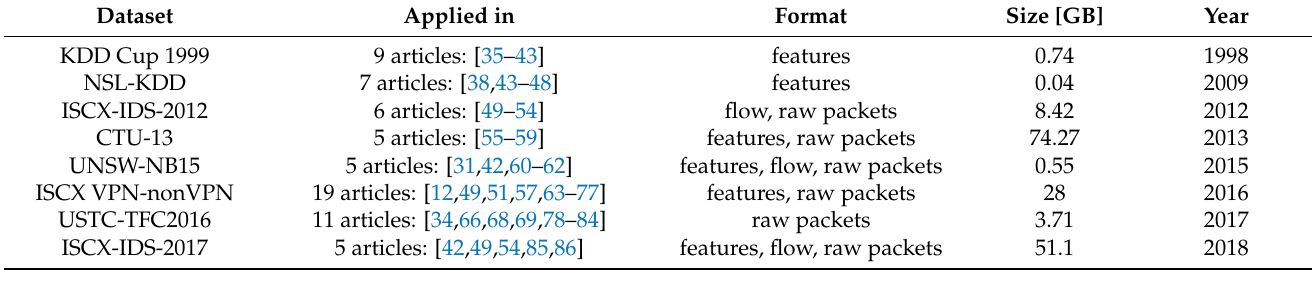
Table 1. The summary of the most popular datasets used in the studied papers—sorted by the year of creation.